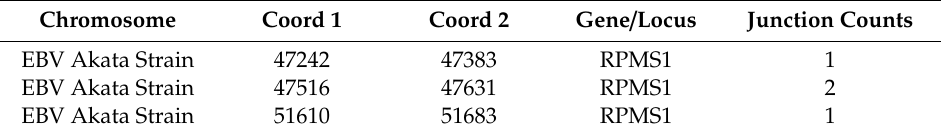
Table 1. Listing of EBV backsplicing read counts in the EBV-high NSCLC sample. Chromosome Coord 1 Coord 2 Gene / Locus Junction Counts EBV Akata Strain 47242 47383